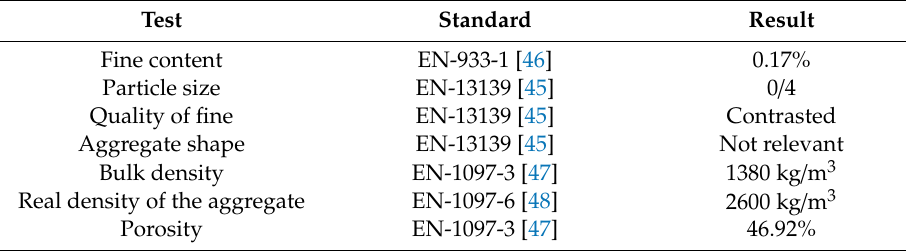
Table 1. Physical characteristics of the